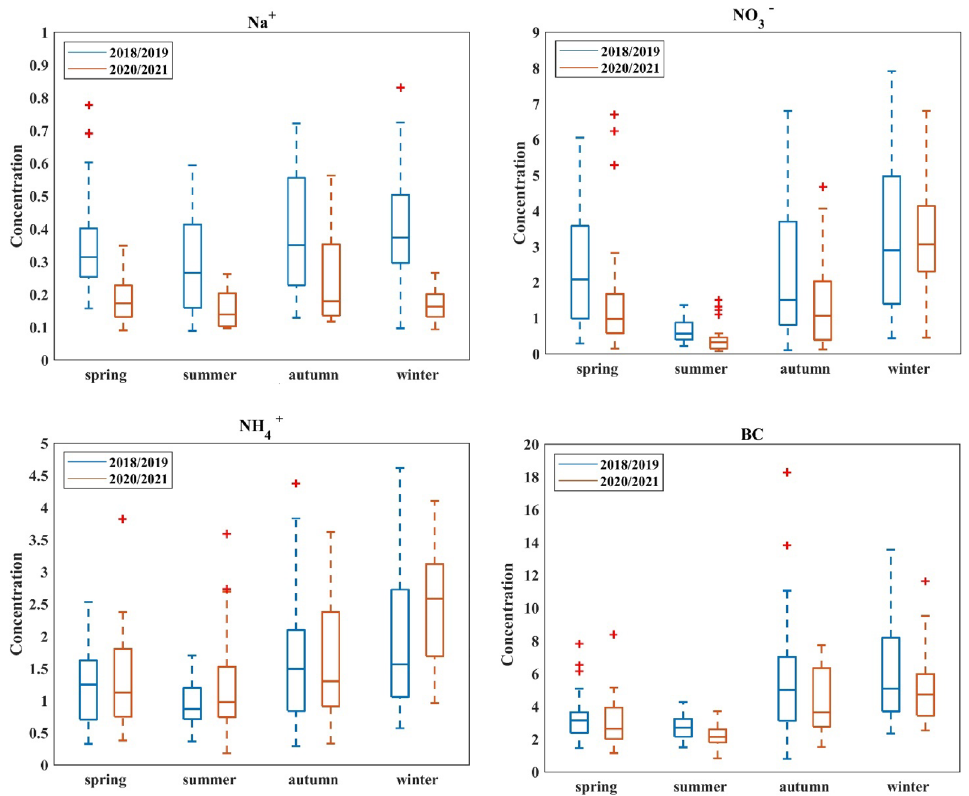
Figure 5. Box plots with interquartile spans and median, minimum, maximum values of ions and eBC concentrations for 2018/2019 and